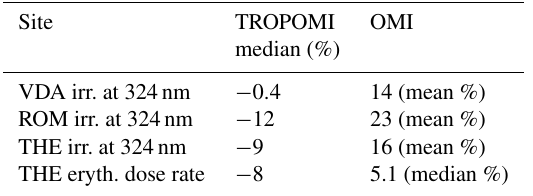
Table 8. OMI irradiance at 324nm validation results (satellite/ground-1) by Arola et al. (2009) together with TROPOMI validation results. For THE, OMI overpass erythemal dose rate comparison results by Zempila et al. (2018) are also